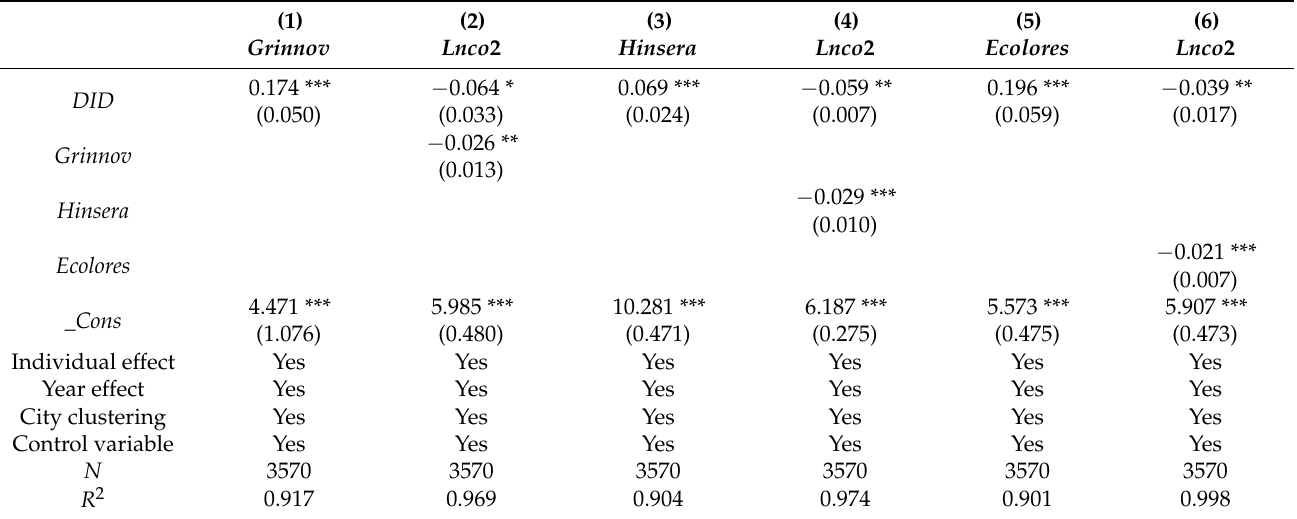
Table 5. Conduction path